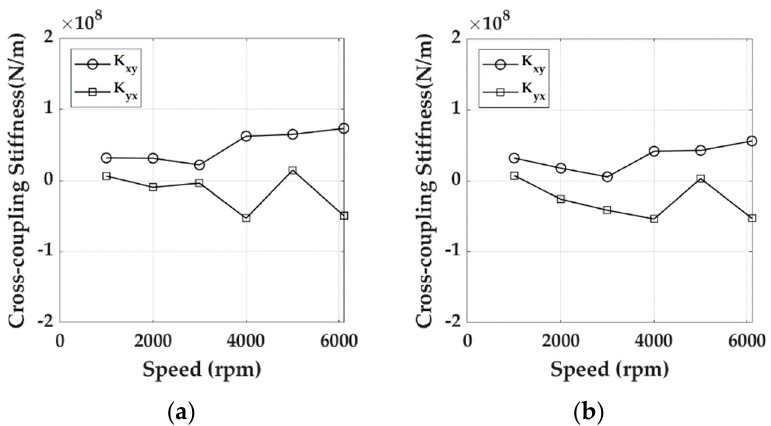
Figure 32. Flooded Ball & Socket Pivot bearing synchronous cross-coupling stiffness: ( a ) 1.0 MPa, ( b ) 1.7 MPa.